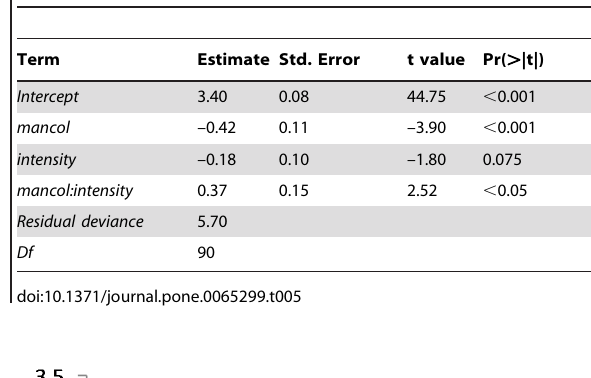
Table 5. Summary of the generalised linear model (glm) used to test the statistical significance of the interactive effect of Manorina colony and land-use intensity on group dispersions based in functional group density data.